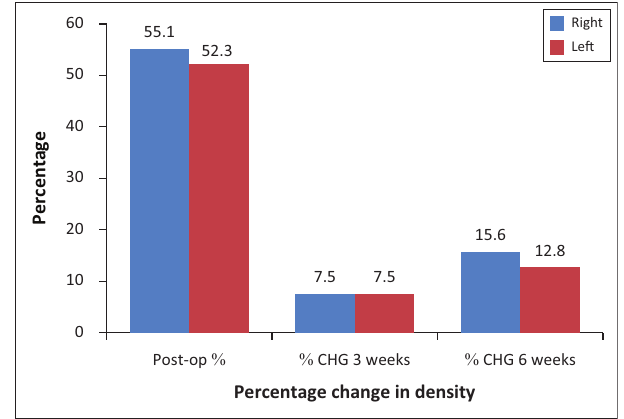
Right Le(cid:31)